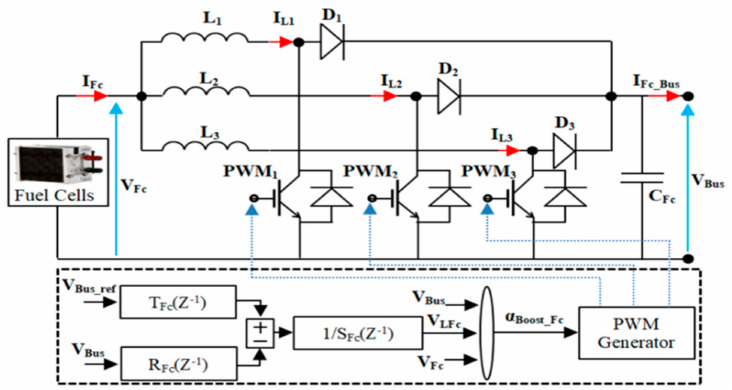
Figure 13. DC-link voltage control loop. Table 4. System control parameters.